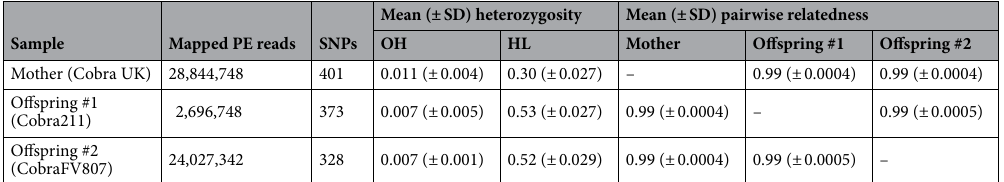
Table 1. Measures of the number of paired-end reads mapped to the king cobra, O. hannah , reference genome, the number of SNPs vs. the reference genome in final thinned genotype dataset, mean heterozygosity ( OH observed heterozygosity, HL homozygosity by loci), and mean pairwise relatedness for all samples. Values above the diagonal in the relatedness matrix represent B xy , while values below the diagonal represent M xy . SD standard